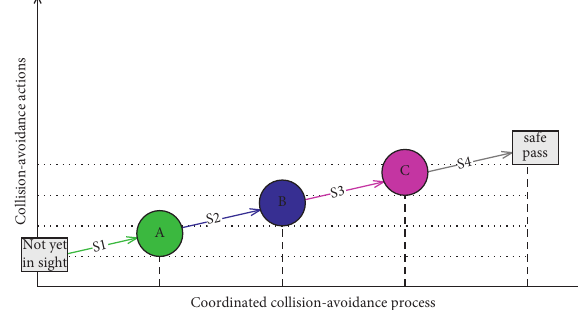
Figure 3: Coordinated avoidance process for two ships approaching each other in an inland waterway. A: understanding each other’s movements. B: unifying collision-avoidance